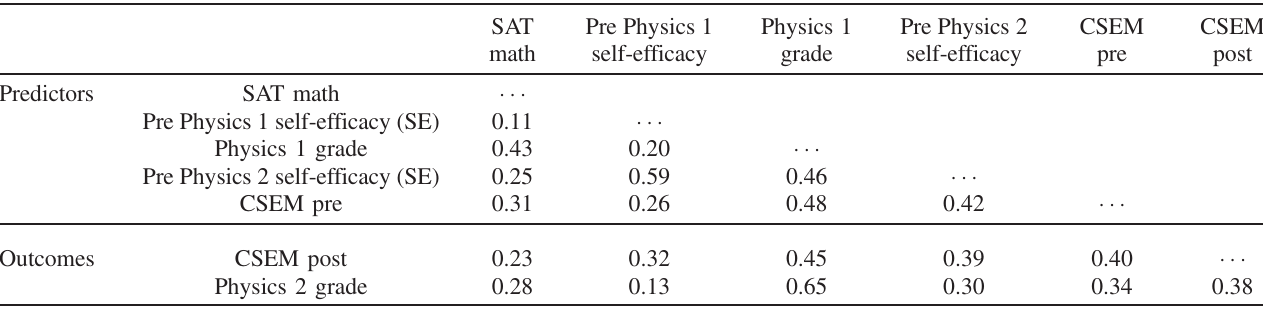
TABLE III. Pearson intercorrelations are given between all the predictors. Below the thick line shows the correlations between predictors and the learning outcomes (CSEM post and Physics 2 grade). The rightmost column shows the correlation between the two learning